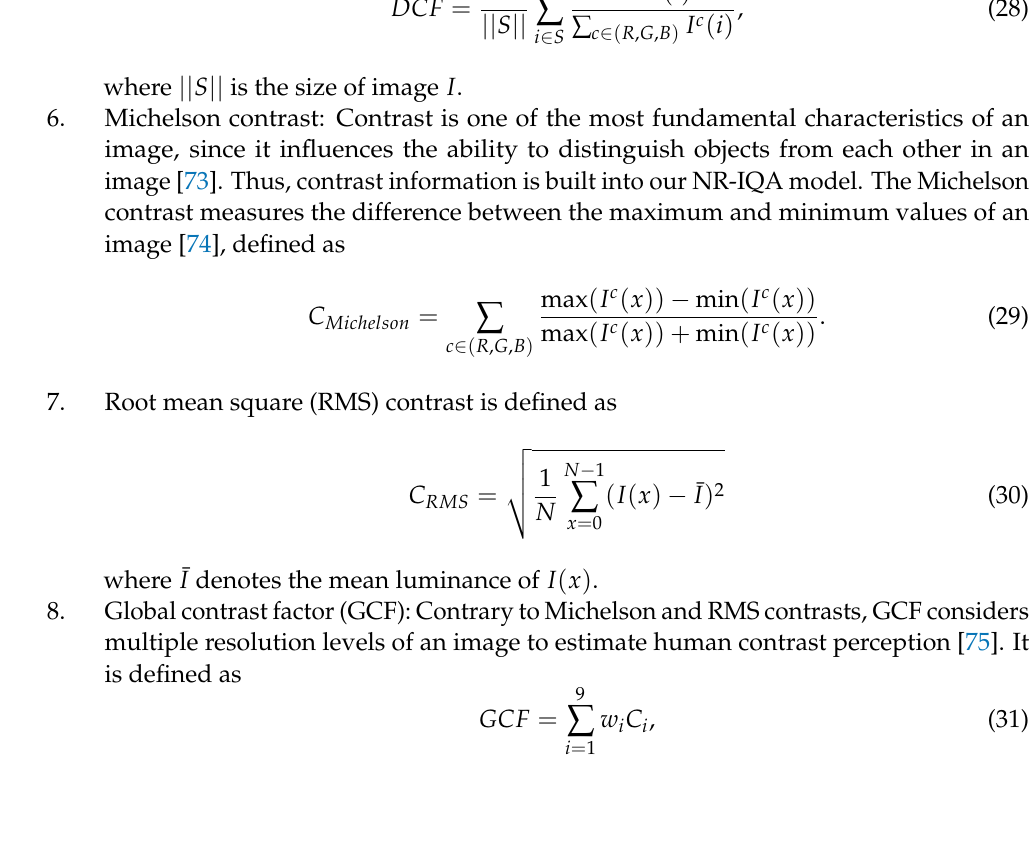
where I x ( x ) and I y ( x ) stand for the approximate directional derivatives in the hor- izontal x and vertical y directions of I ( x ) , respectively. In our study, the mean and standard deviations of CGM ( x ) are utilized as quality-aware features. 5. Dark channel feature (DCF): In the literature, Tang et al. [71] proposed DCF [72] for image quality assessment, since it can effectively identify haze effects in images. A dark channel is defined as